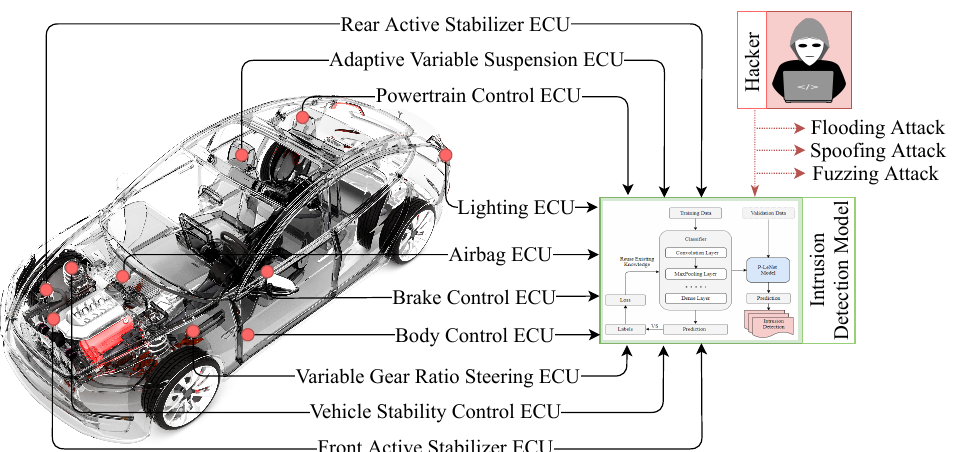
Figure 4. Application of intrusion detection model for IVN traffic. The figure illustrates how the proposed IDS can detect the possible attack vectors within an in-vehicle Network. The car image is adopted from [47].